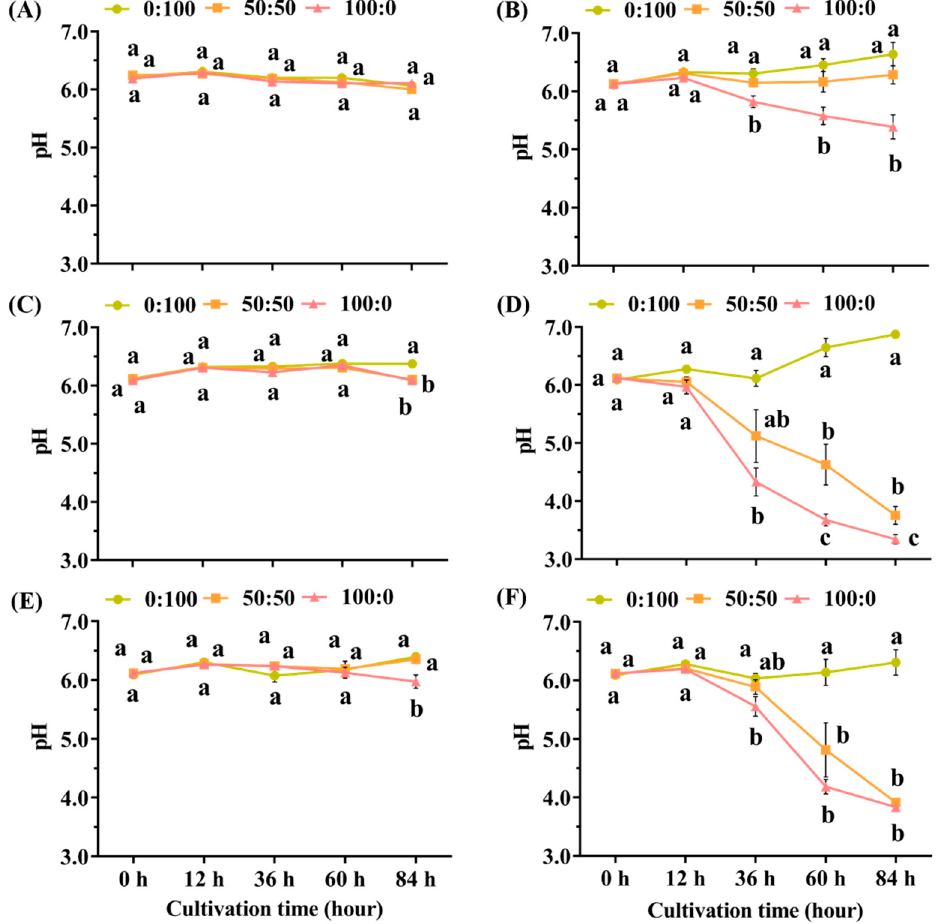
Figure 3. Time course changes in the pH of hydroponic solutions supplied with three NH 4+ :NO 3 − ratios, as affected by 5 species during an 84 h cultivation. ( A ) Control without plants; ( B ) salvia; ( C ) petunia; ( D ) ageratum; ( E ) cabbage; and ( F ) lettuce. Data are expressed as means ± SD of n = 3 biological replicates. p less than 0.05 was considered significantly different, indicated by different lower case letters according to the one-way ANOVA (Duncan’s multiple range test).